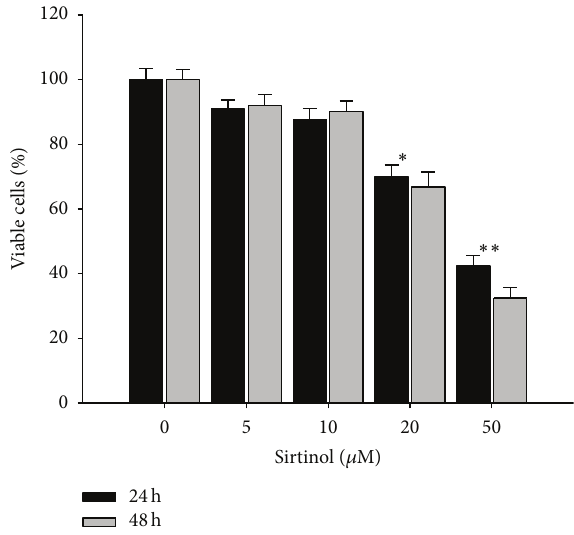
Figure 1: Effect of sirtinol on cellular proliferation of H1299 cells. H1299 cells treated with different concentrations (5, 10, 20 and 50 𝜇 M) of sirtinol for 24 h and 48h, respectively. The cell survival was determined by the trypan blue staining assay combined with the Countess Automated Cell Counter. ∗∗ 𝑃 < 0.001 against vehicle